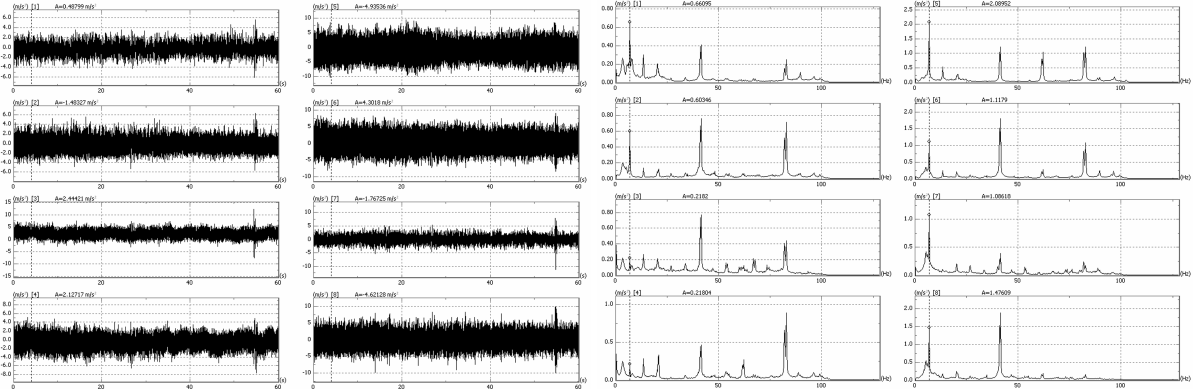
Fig. 10 Waveform and spectrum of each measuring point at a speed of 80 Km/h.